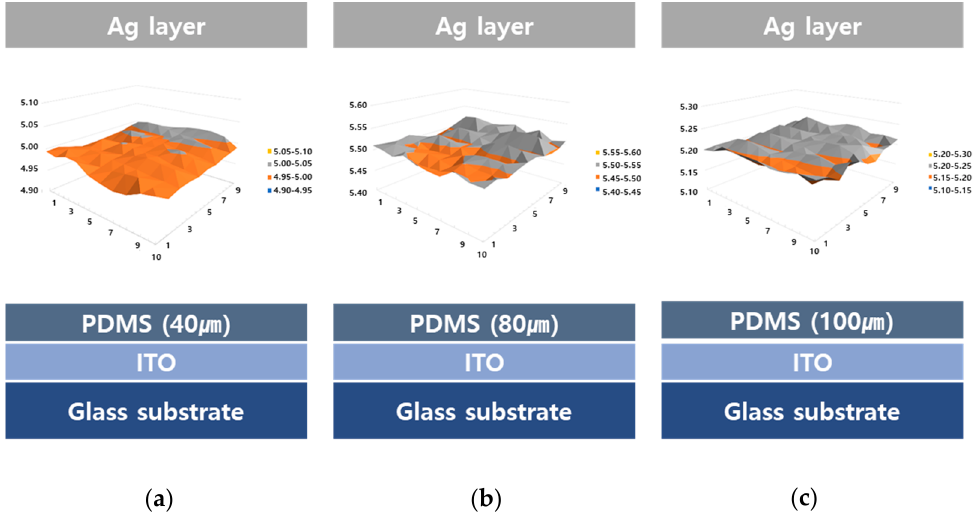
Figure 7. Work function distribution of polydimethylsiloxane (PDMS) layers of various thickness, ( a ) 40, ( b ) 8, ( c ) 100 μ m, on indium tin oxide-coated (ITO) substrate.